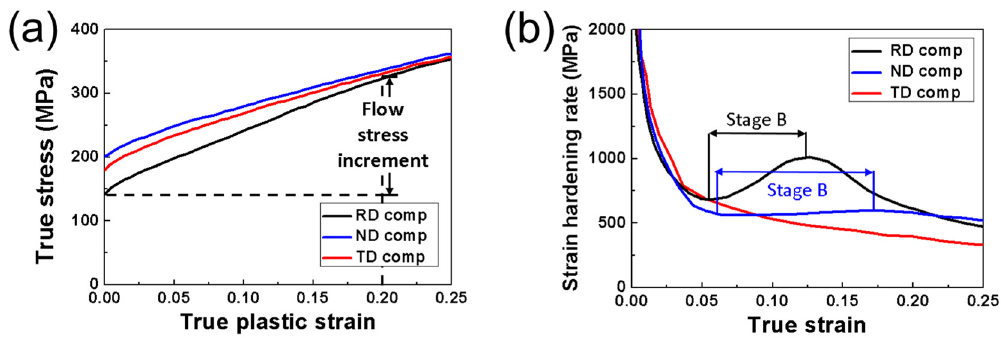
Figure 3. Compressive deformation behavior of CP-Ti (commercially pure titanium) depending on the loading direction: ( a ) flow stress curves starting from the yield point and ( b ) strain-hardening rates.